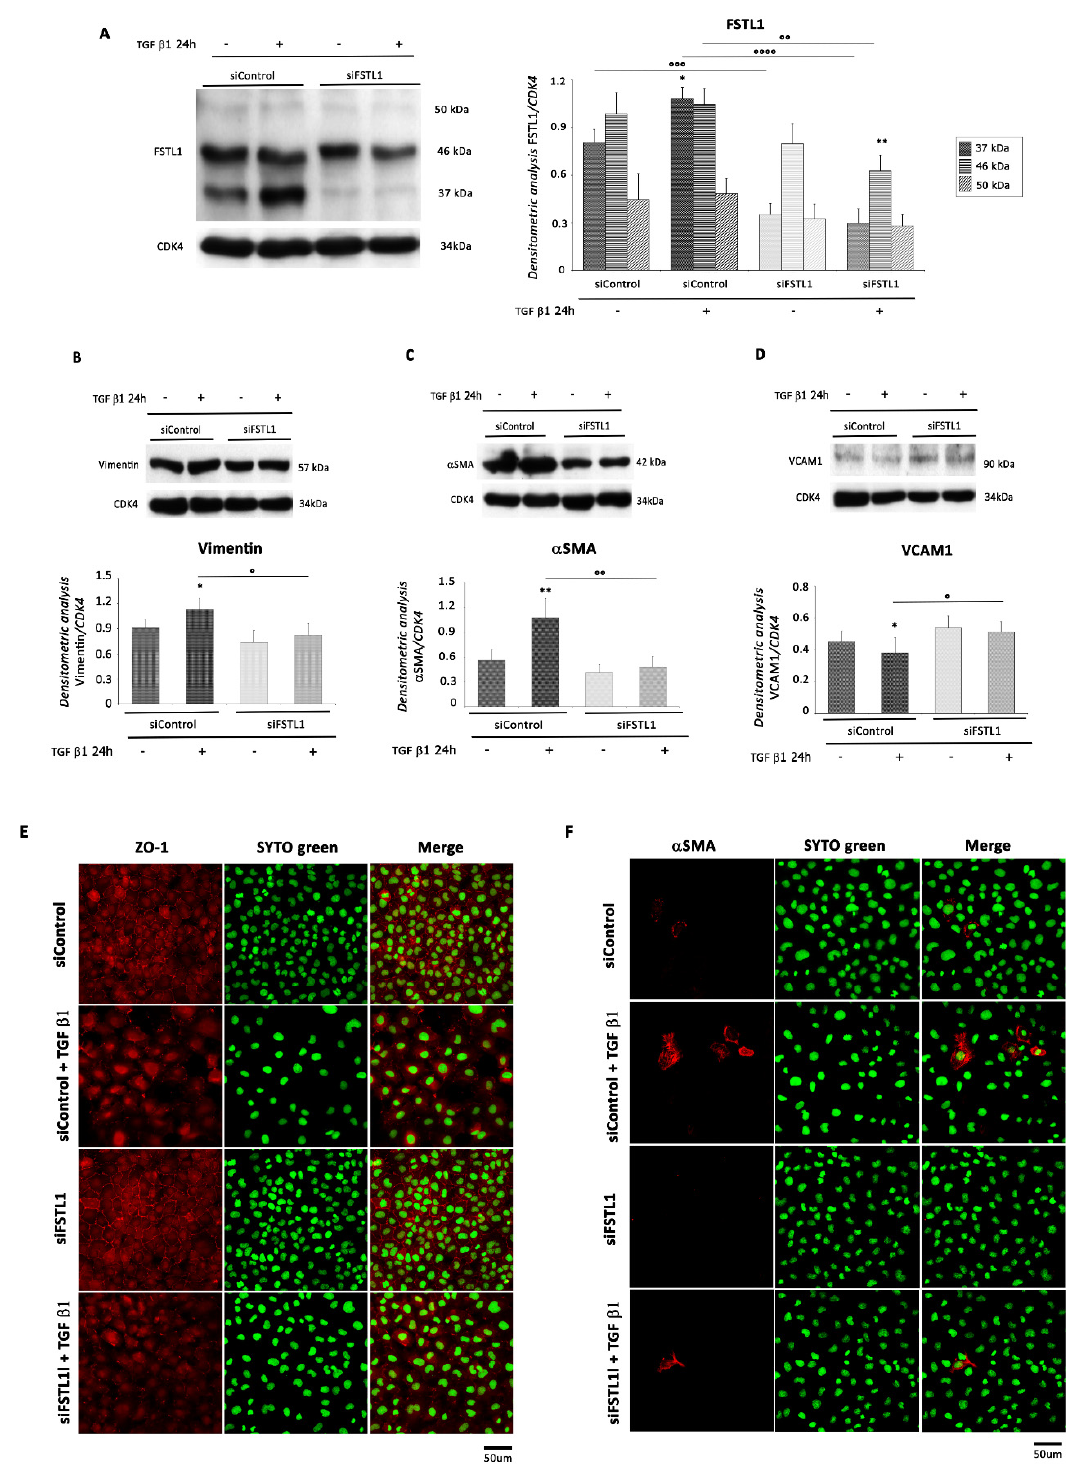
Figure 8. FSTL1 knockdown reverses EMT. EMC cells were transfected with control siRNA (siControl) or siRNA directed against FSTL1 (siFSTL1) and then treated or not with TGF β 1 (1 ng/mL) for additional 24 h starting from the day after transfection. WB analysis performed with antibodies against ( A ) FSTL1, ( B ) Vimentin, ( C ) α SMA, and ( D ) VCAM1. CDK4 was used as loading control. Upper panel (or left panel for FSTL1): A representative Western blotting of three independent experiments is shown. Lower panel (or right panel for FSTL1): Densitometric analysis of Western blot. Data are shown as means ± SEM. *, p < 0.05 vs. siControl, **, p < 0.005 vs. siFSTL, two-tailed Student’s t -test; °, p < 0.05, °°, p < 0.005, °°°, p < 0.0007, °°°°, p < 0.0001, two-way ANOVA, Bonferroni post hoc test. ( E , F ) Representative images of EMCs immunostained